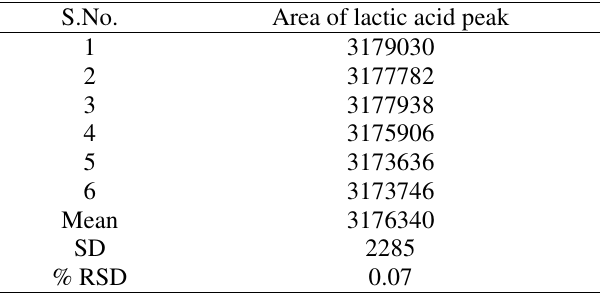
Table 2. Summary of precision results